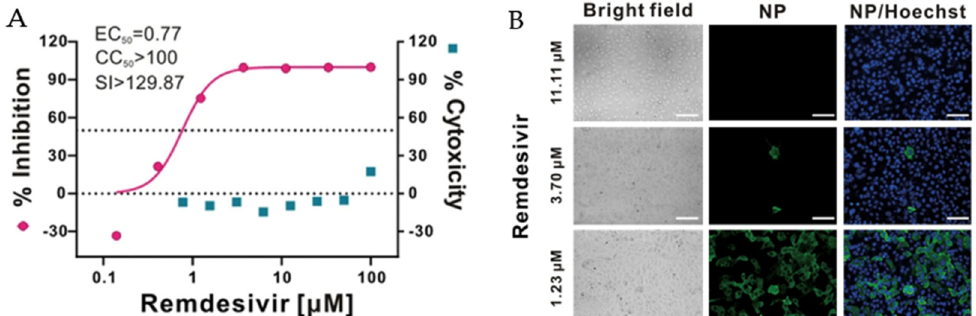
Figure 10. ( A ) Percentage of inhibition measured by qRT-PCR and cytotoxicity of Remdesivir ® when used to treat SARS-CoV-2-infected Vero E6 cells. ( B ) Immunofluorescence assay of viral infection with Remdesivir ® treatment [43].